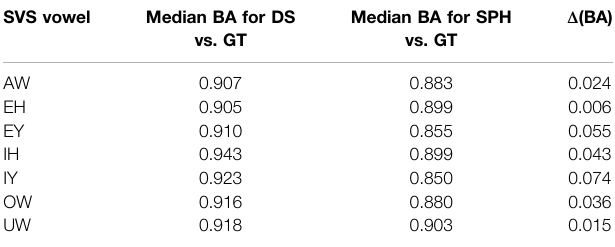
TABLE 1 | Bhattacharyya ’ s Af fi nity for DeepSpeech versus ground truth and Sphinx versus ground truth in Southern speakers. BA score 1.0 (cid:1) perfectly overlapping distributions, 0.0 (cid:1) completely non-overlapping. Δ SVS vowel Median BA for DS Median BA for SPH vs. GT vs. GT